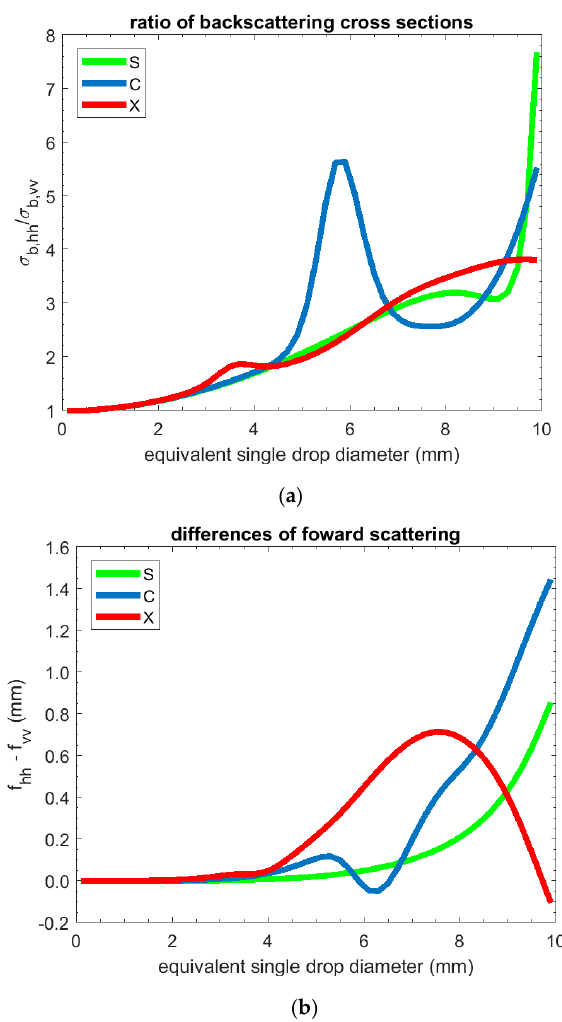
Figure 4. As for Figure 2, but for X-band. ( a ) IFloodS 2DVD dataset; ( b ) HyMeX 2DVD dataset; ( c )